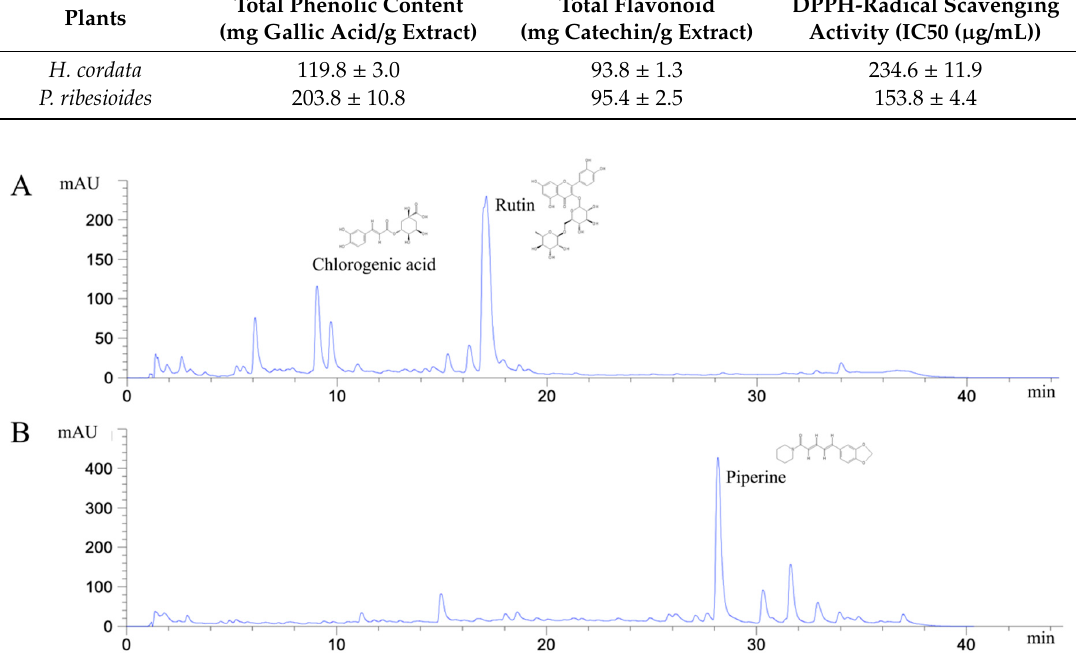
Figure 1. HPLC chromatograms of ethanolic H. cordata extract ( A ) and P. ribesioides extract ( B ).